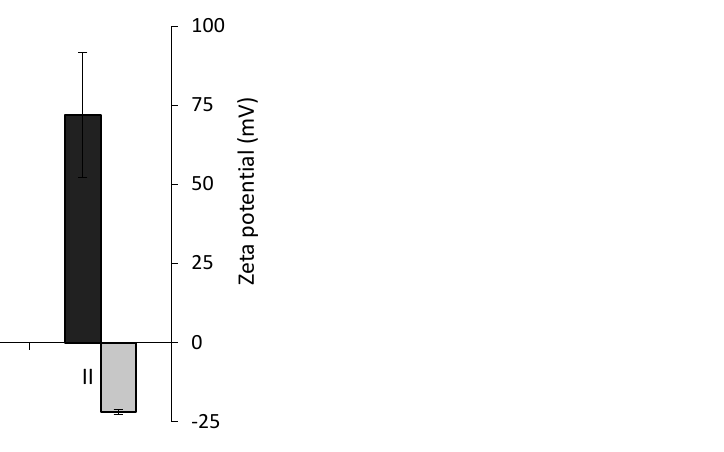
Figure 7. Hydrodynamic diameter (1) and zeta potential (2) values of AuNPs synthesized by R. erythropolis IEGM 766 (I) and R. ruber IEGM 1135 (II). Table 1. Elemental composition (%) of the SEM preparations with biosynthesized AuNPs. Rhodococcus Strains